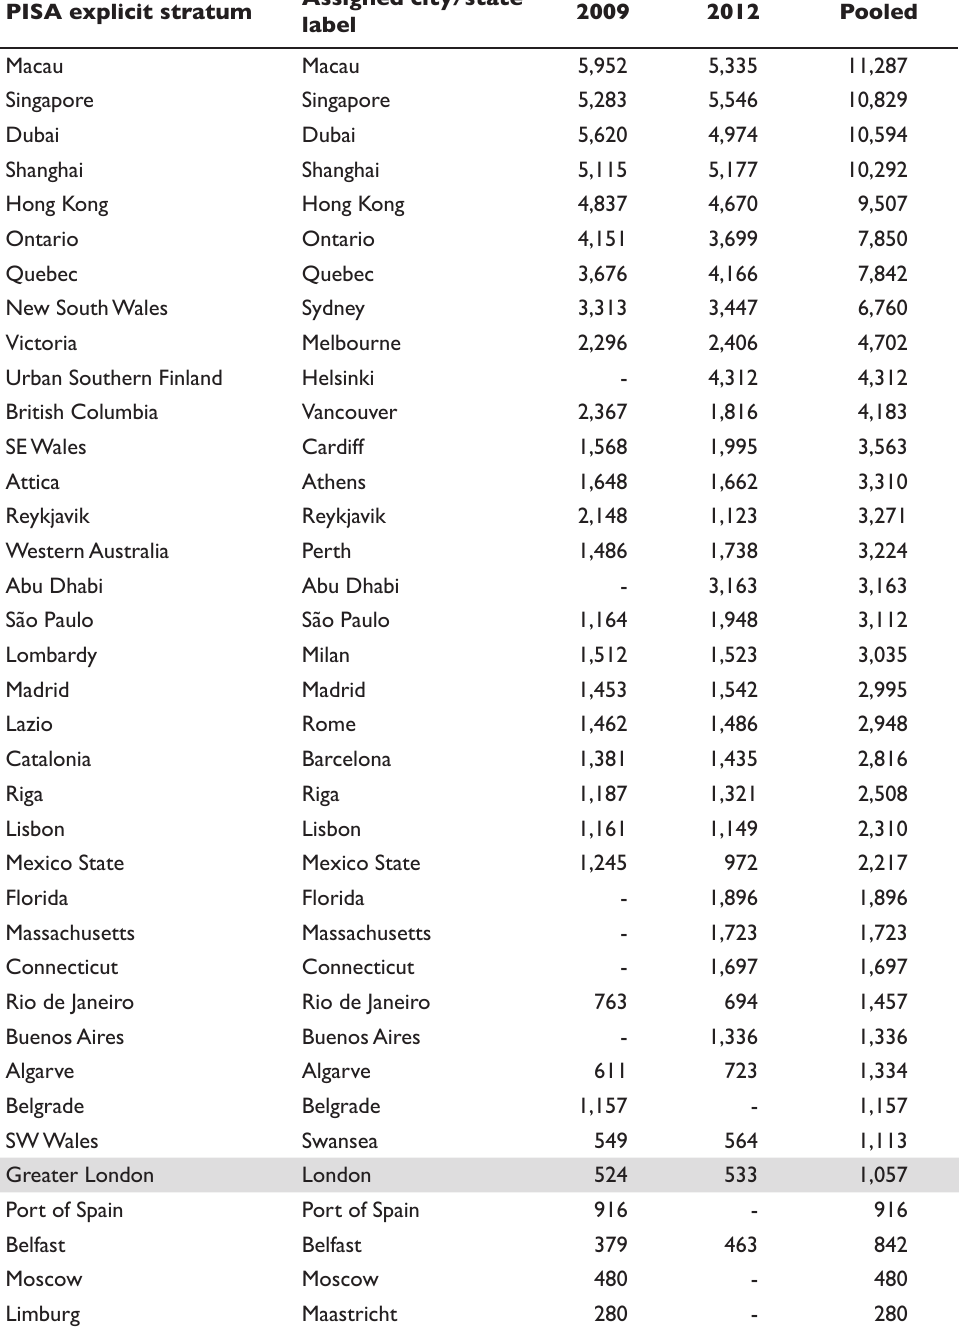
Table 1: Samplesizesforcities/states PISA explicit